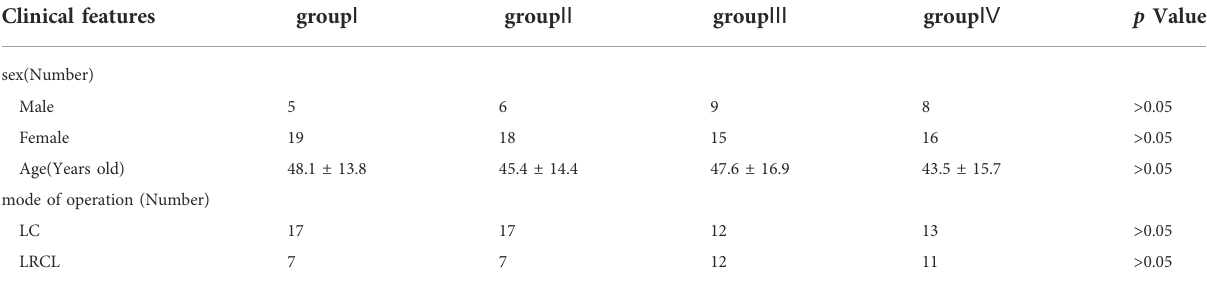
LC: laparoscopic cholecystectomy. LRCL: Laparoscopic choledochoscope combined with minimally invasive gallbladder-preserving lithotomy.